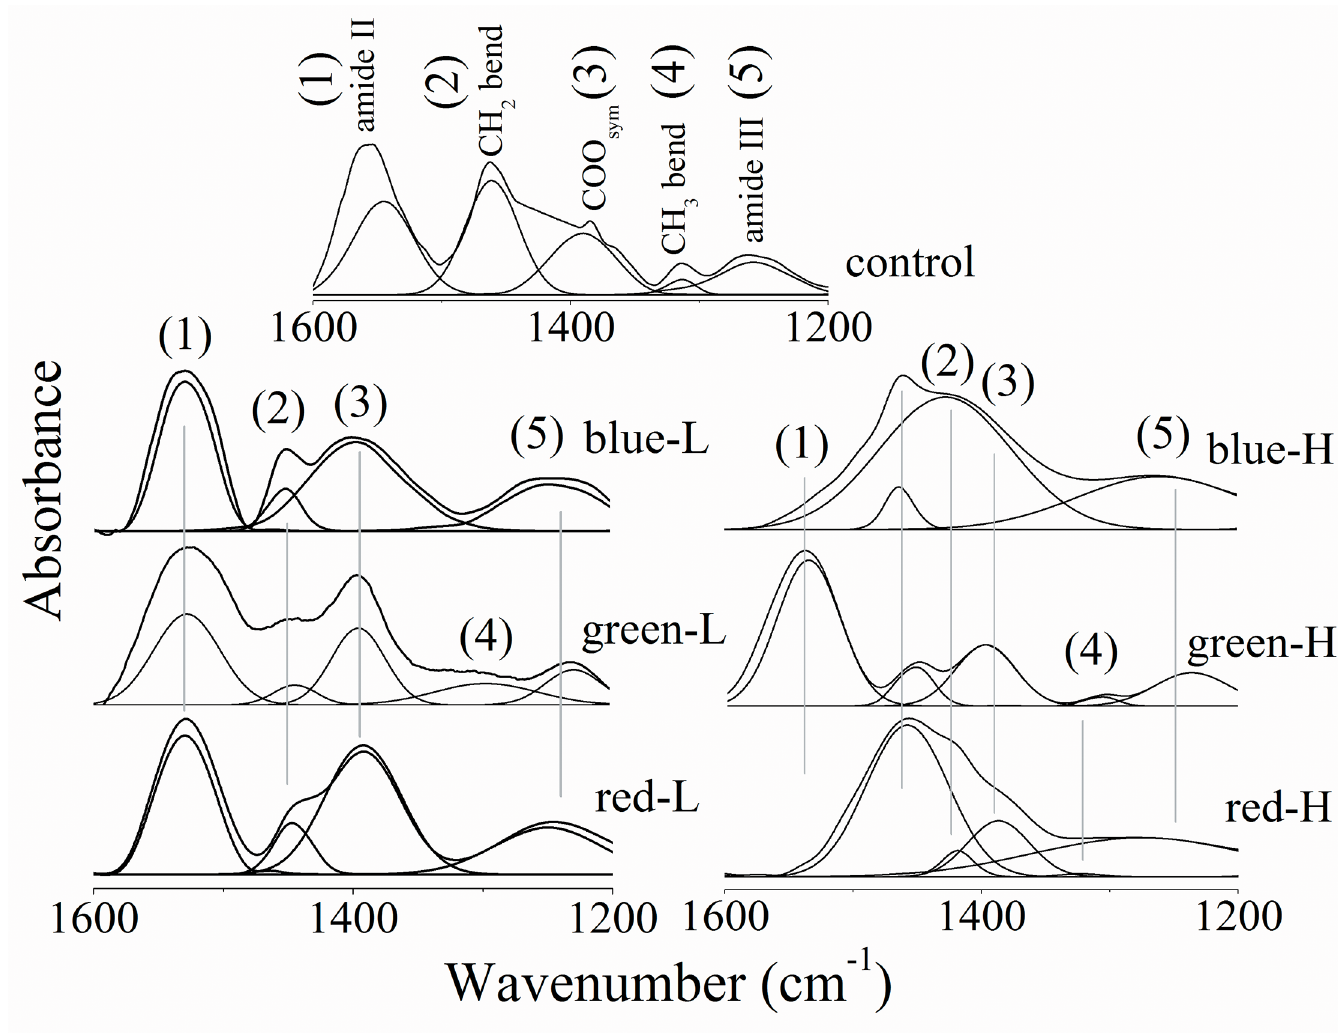
Fig 4. Fingerprint vibrations of corneas from all studied groups showing the underlying peaks.